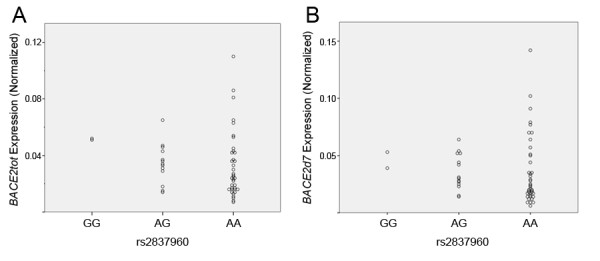
Quantification of BACE2tot and BACE2d7 in human brain. Real-time PCR with isoform-specific primers was used to quantify the expression of BACE2tot and BACE2d7 in cDNA prepared from human brain. (A-B) Samples exhibit a trend toward increased expression of both BACE2tot and BACE2d7 in the presence of rs2837960_G (p = 0.07 and p = 0.10, respectively, using Jonckheere-Terpstra testing).